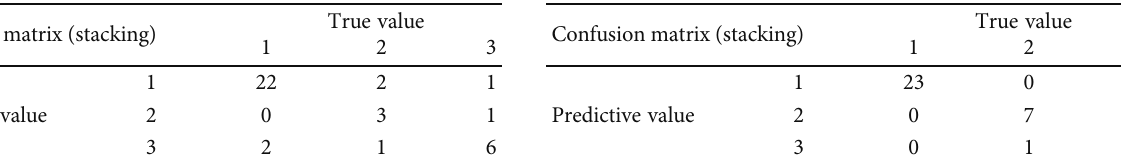
Table 4: Confusion matrix of prediction results of the stacking integrated model ROP grade.